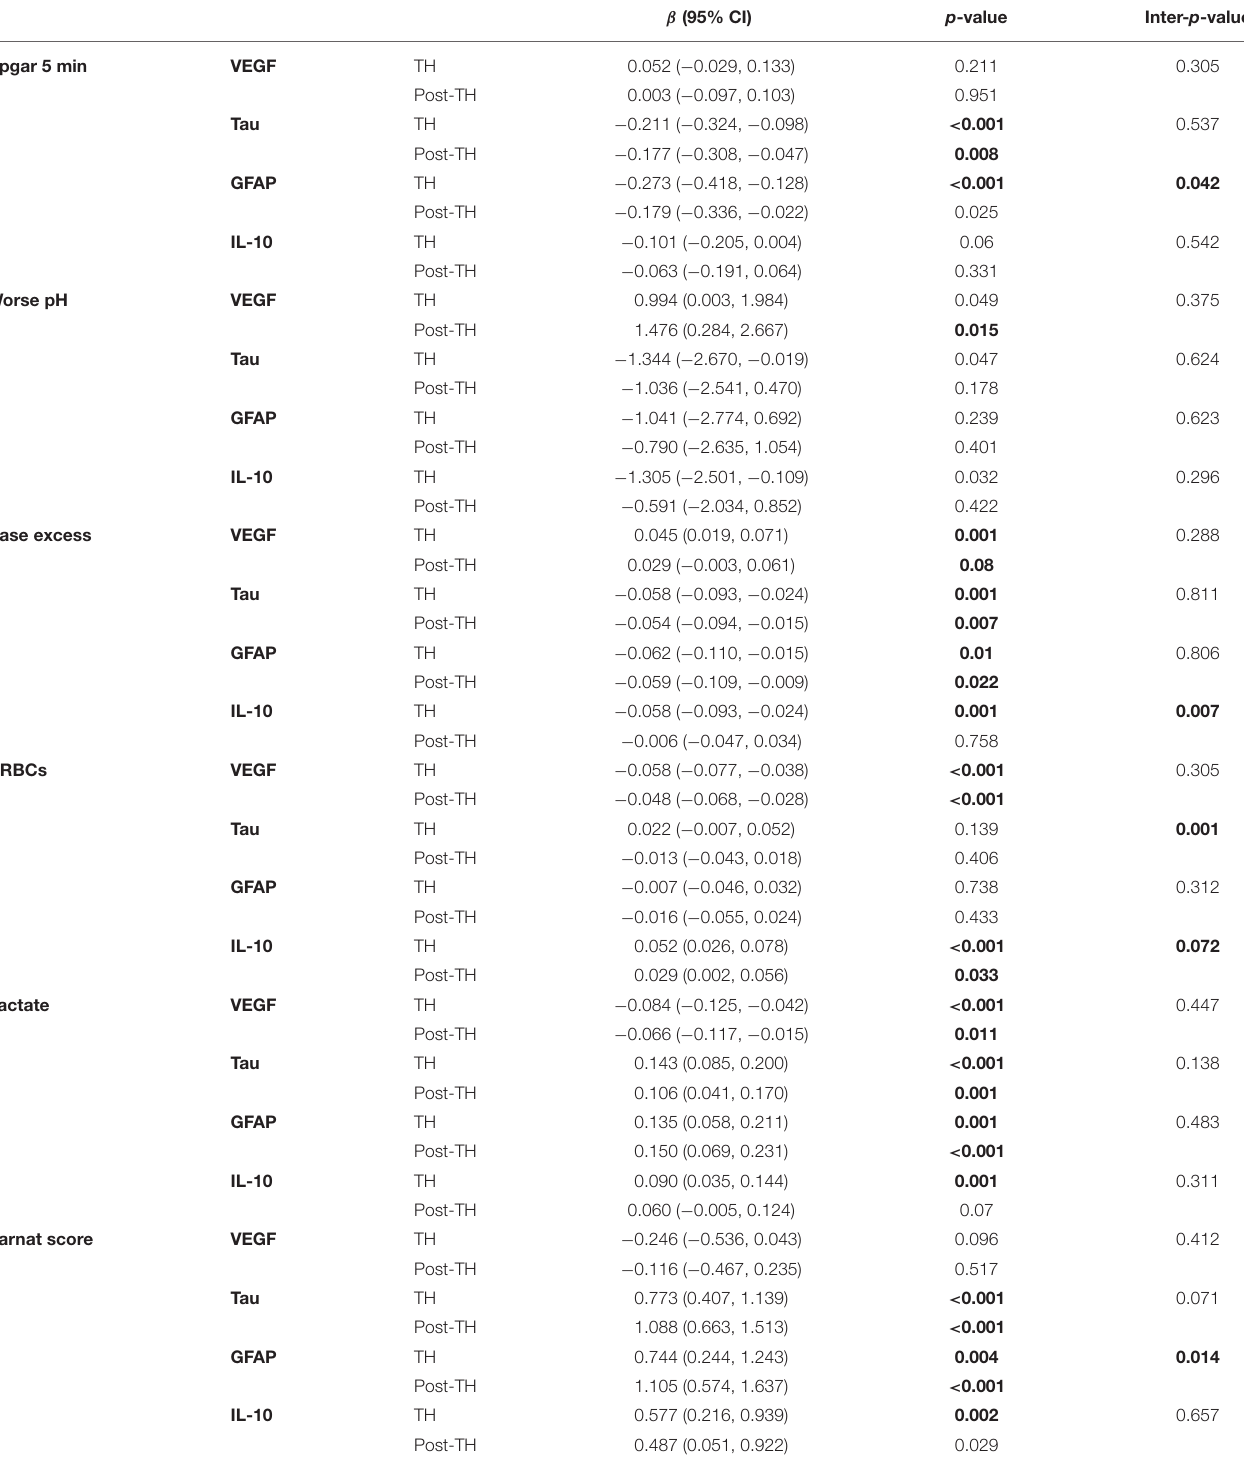
Mixed-model analysis with adjustments. GFAP, glial fibrillary acidic protein; NRBCs, nucleated red blood cells; PI score, perinatal Insult score; TH, therapeutic hypothermia; VEGF, vascular endothelial growth factor. Bold represent p-values <